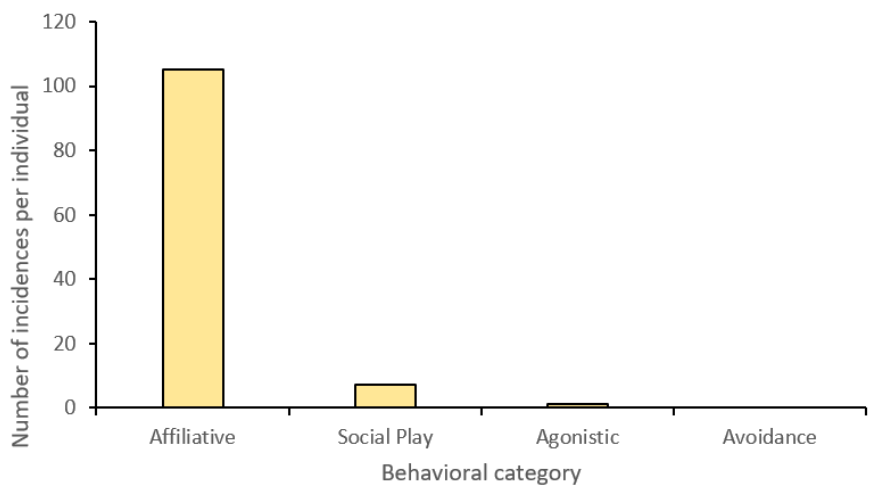
Figure 5. Behavioral category frequency for social interactions between the male (Sirius) tiger and the two cubs (Serikin and Shima) (undirected) at Parc des Félins.